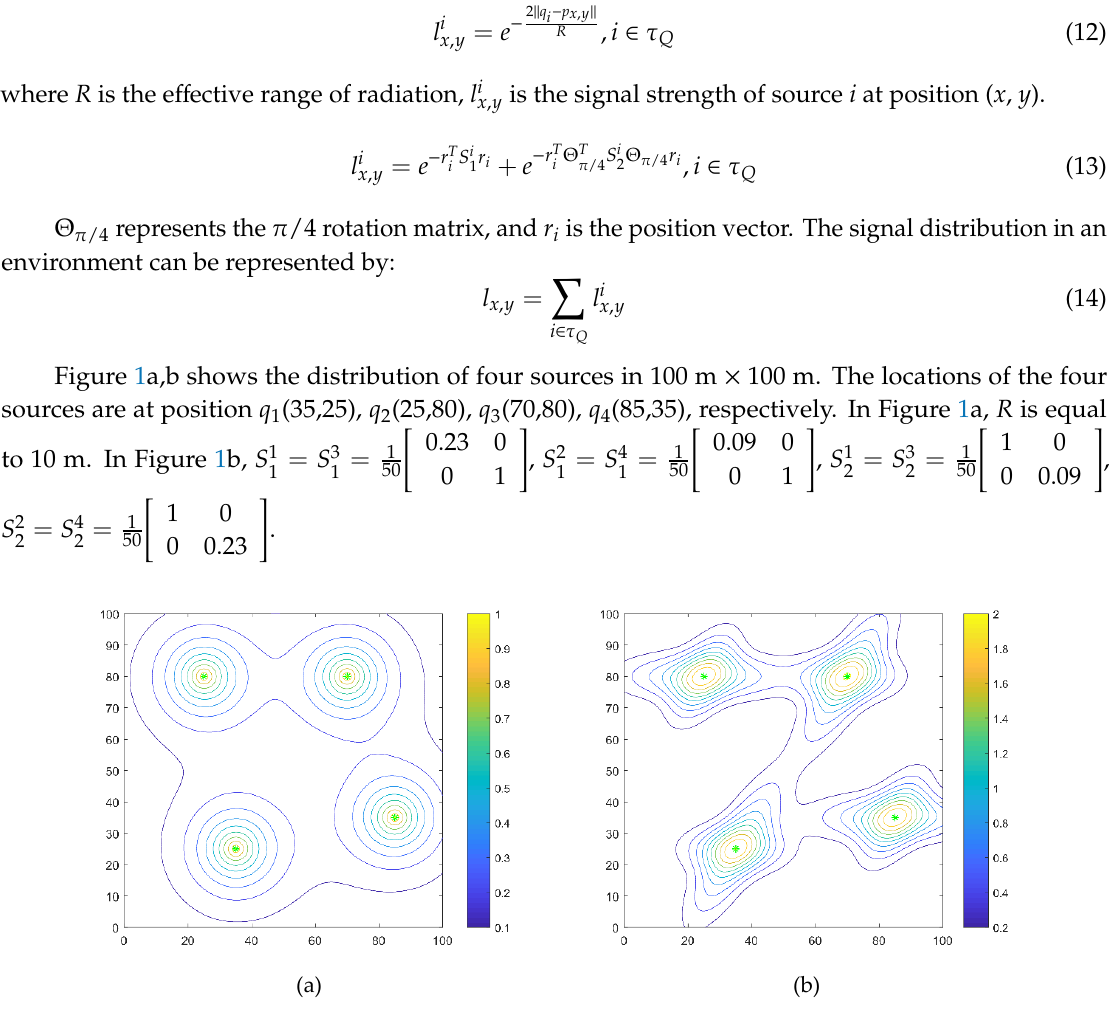
Figure 1. The received signal strength distribution. ( a ) the received signal strength distribution of isotropic signals; ( b ) the received signal strength distribution of anisotropic signals.